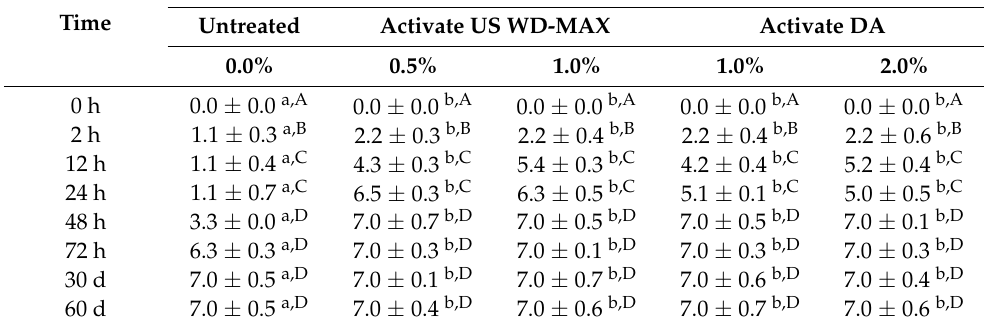
organic acid, no inoculation).